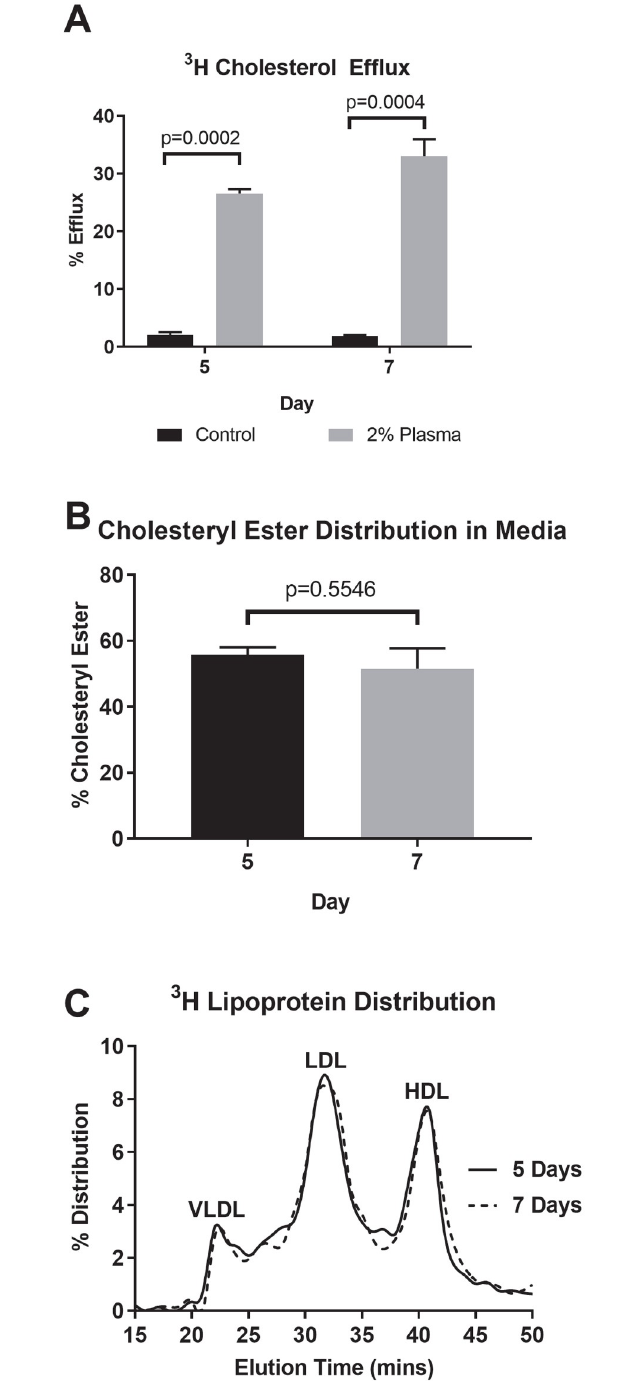
Fig 3. Cholesterol efflux from 3D cultured hepatic constructs. Cholesterol efflux supported by lipoproteins is a key property of hepatocytes. To assess efflux, PHH were cultured in 3D and radiolabeled with 3 H-cholesterol for 24 hours after 5 and 7 days post culture. (A) Hepatocytes were subsequently washed and incubated with 2% human plasma or 2% BSA to initiate efflux over a 4 hour time frame. Incubating hepatocytes with media containing 2% plasma resulted in significant radiolabeled cholesterol efflux compared to cultures incubated with 2% BSA alone. Mean ± standard error of the mean is reported. There were no significant differences in cholesterol efflux between hepatic constructs cultured at days 5 and 7. (B) The proportion of radiolabeled cholesteryl ester in media was quantified, revealing more than 51% of the cholesterol efflux from the cultures was recovered as cholesteryl ester on days 5 and 7. (C) Media from